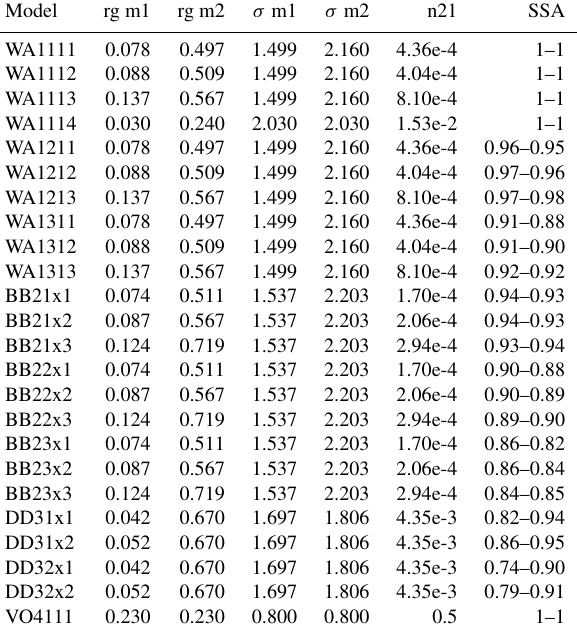
Table 1. Aerosol size distribution parameters and wavelength de- pendent single-scattering albedo (SSA) for aerosol microphysical models stored in LUTs. The third digit (“x”) in the model ID num- ber for BB and DD models has a range of 1–3 and is intended for different vertical distributions. The size distribution is given by log- normal functions. The mean particle radius, rg [micron], and the standard deviation, σ [micron], are given for both modes, m1 and m2. A second mode fraction of the number concentration is given in column n21. The SSA values shown here are for the first and last wavelength bands.